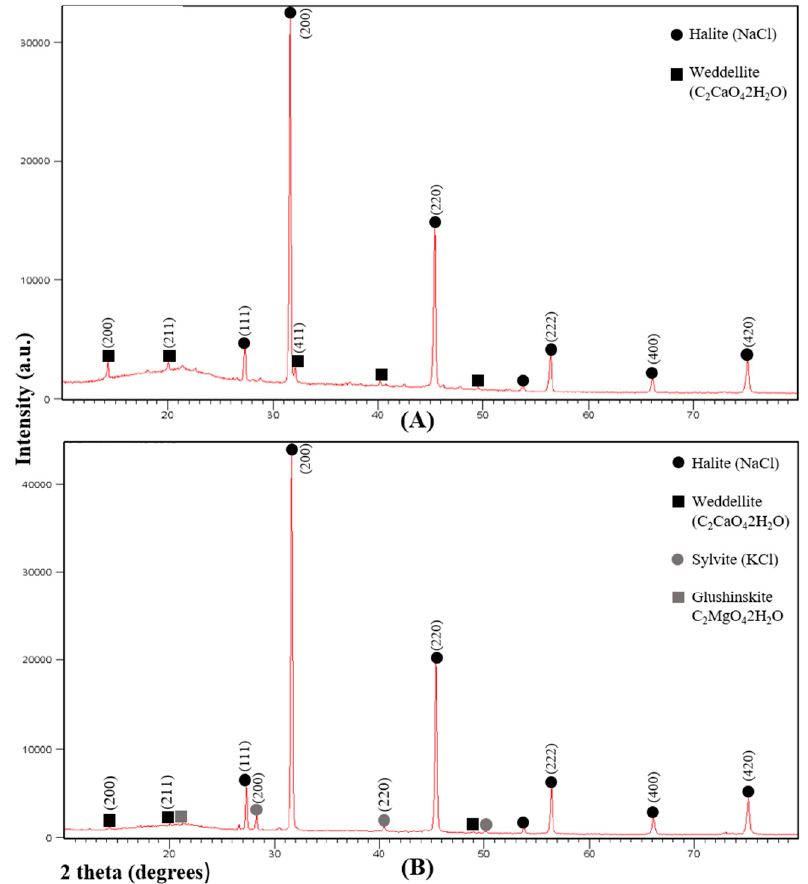
Figure 1. Representative X-ray diffraction spectra of succulent stems of S. pruinosa . ( A ) Halite and weddellite. ( B ) Halite, weddellite, sylvite and glushinskite. Numbers in parentheses in the most intense peaks refer to the crystallographic planes ( hkl ).